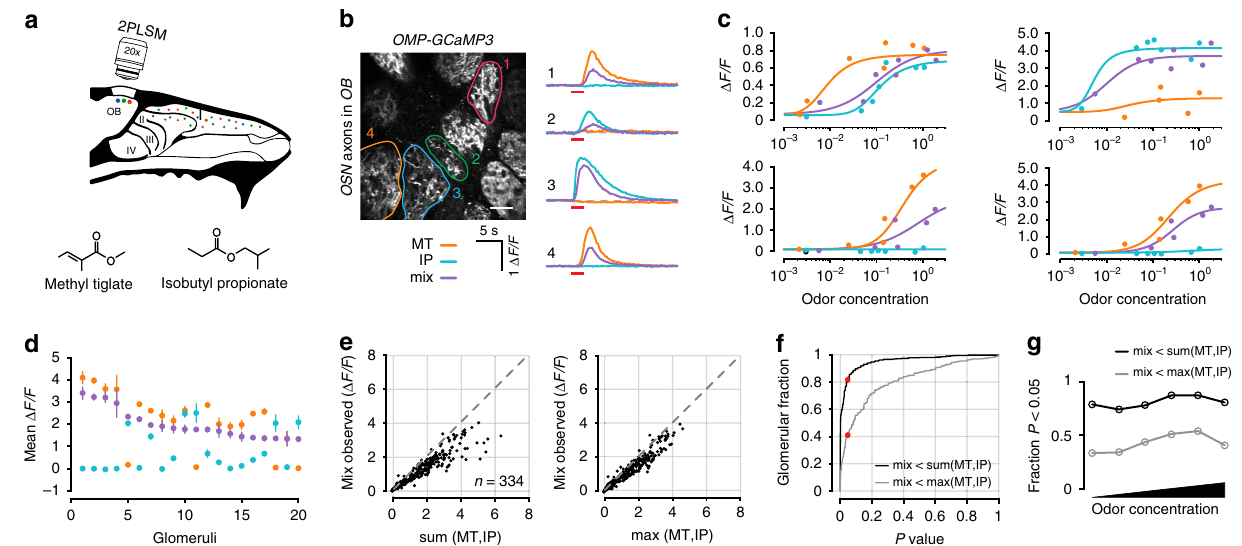
Fig. 2 Optical measurements of antagonism in OSN axon terminals. a Experimental setup. Odor responses in OSN axon terminals were measured at olfactory bulb glomeruli through a cranial window. b Example image of glomeruli and selected ROIs from one of nine mice in this dataset. Responses for two odors (Methyl tiglate and Isobutyl propionate) and their mixture from selected glomeruli are shown on right as Δ F/F time courses. Colored circles correspond to ROIs in image. Red bar under traces denotes odor delivery time. Scale bar in image is 50 µ m. c Example dose response curves from four selected glomeruli. Each point is the average of 3 – 5 trials. Odor concentrations are normalized to the largest measured concentration (see Methods). For each point, odor mixtures are the summation of both individual odors. d Data from 20 randomly selected glomeruli. Each point is the mean of the three largest responses from each odor. Error bars are SEM. e Left, comparison of the observed mixture response against the linear sum of both mixture components or (right) against the maximum response generated by either mixture component. f Cumulative distribution of rank-sum test P values obtained for 334 glomeruli for linear sum comparison (black) and comparison to maximum component response (grey). Red dots mark P values< 0.05. g Fraction of glomeruli that showed signi fi cant antagonism in each of six concentration bins. Each bin contains three adjacent concentrations.